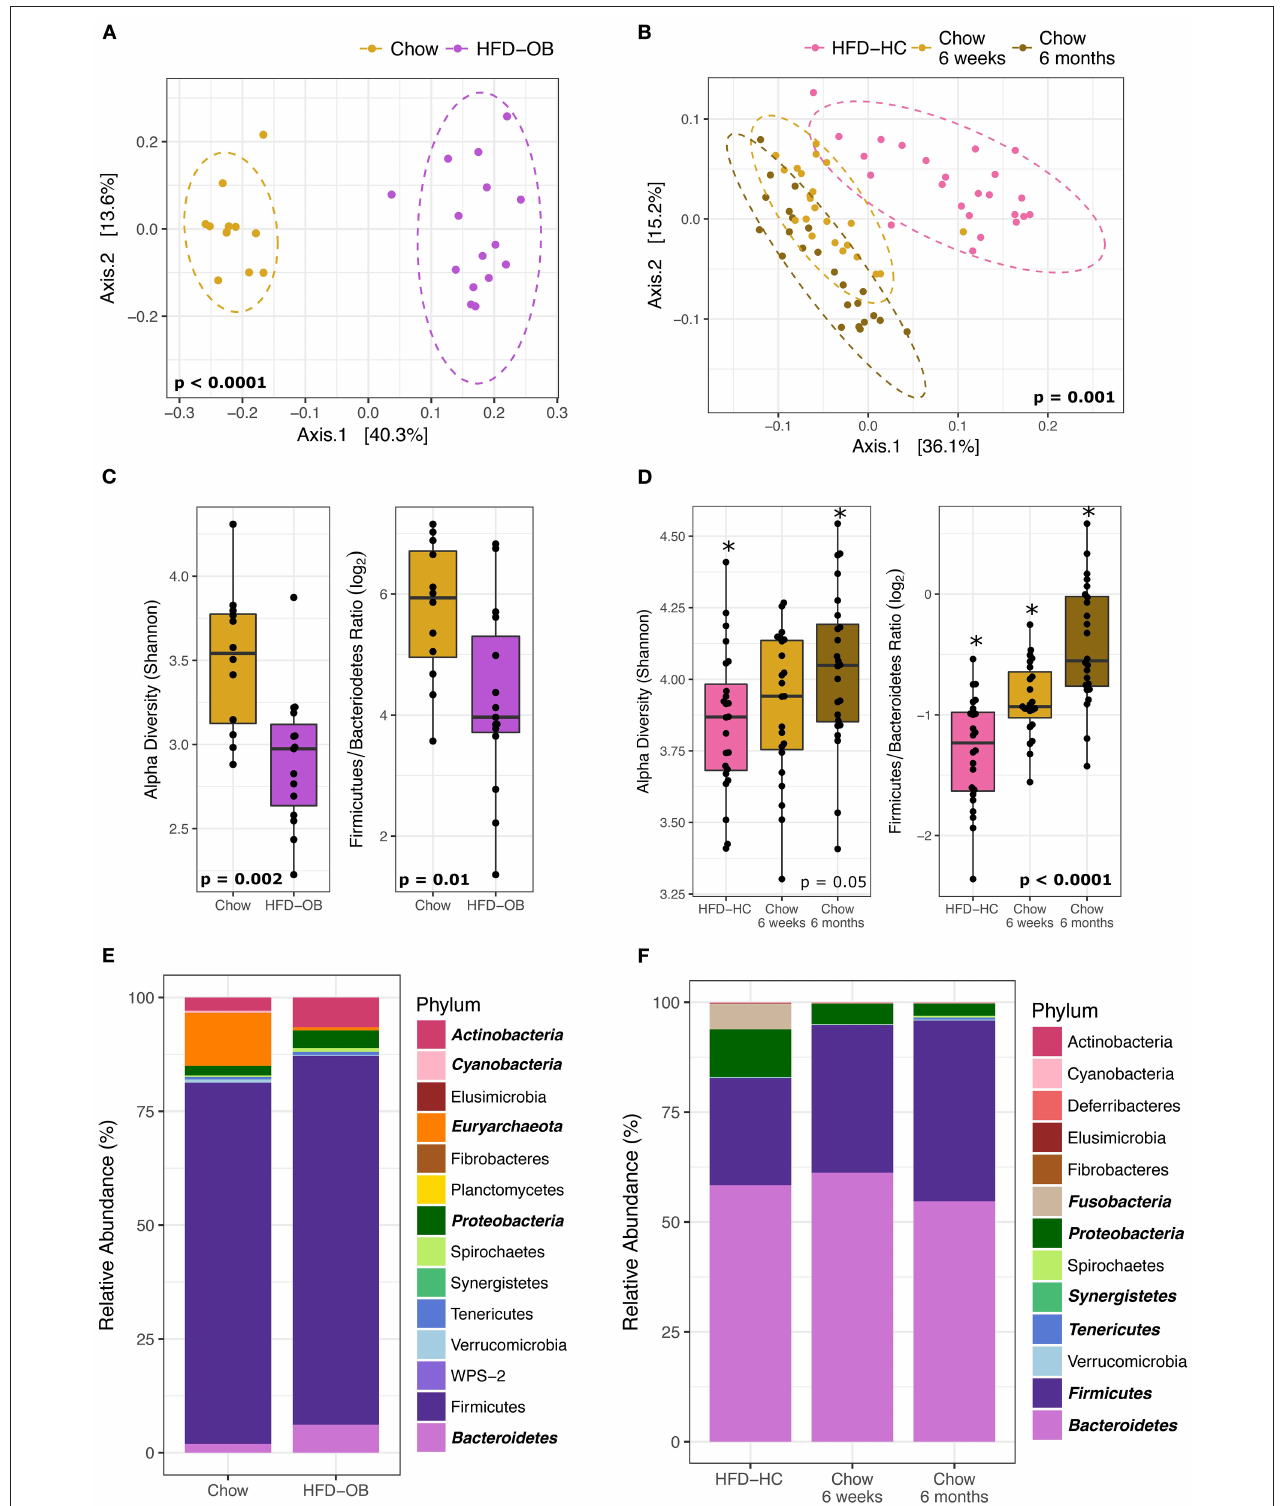
FIGURE 2 | Microbiome changes between high-fat diets and chow are similar even with different diet composition and order. Left panels are the High-fat diet Oleic Blend study and right panels are the Recovery from a High-fat diet study. Ordinations (A, B) were plotted using principal coordinate analysis with weighted Unifrac distance, and groups were compared using non-parametric multivariate analysis of variance (PERMANOVA). Dashed ellipses represent 95% CI from the cluster